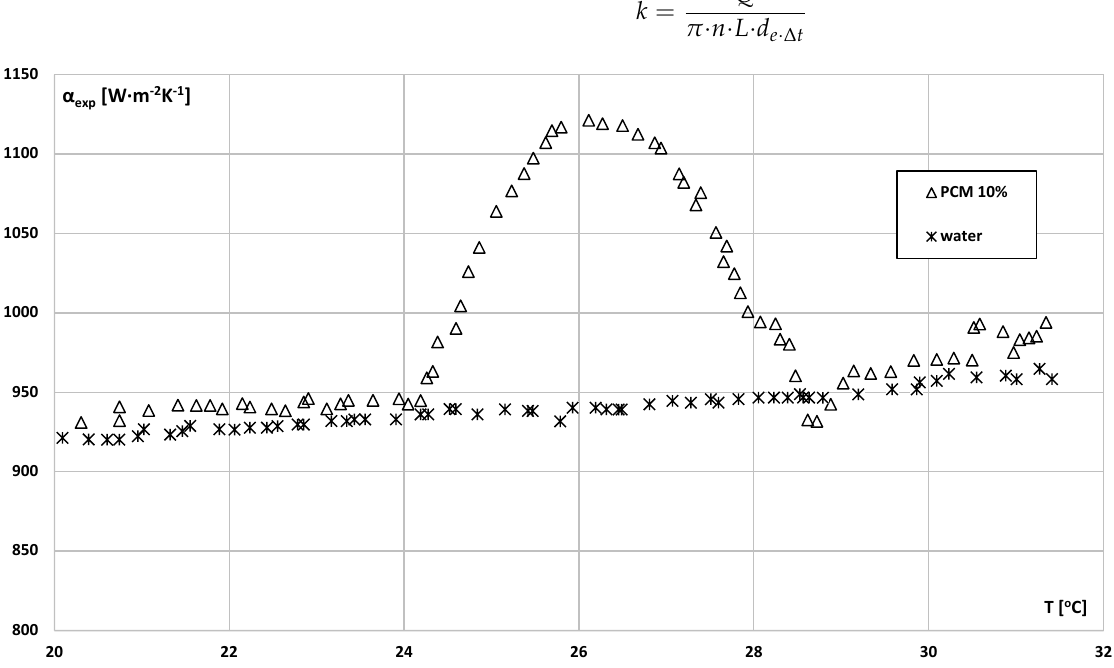
Figure 5. The dependence of the heat transfer coefficient α exp on the coolant temperature at the inlet of the heat exchanger’s cooling section.